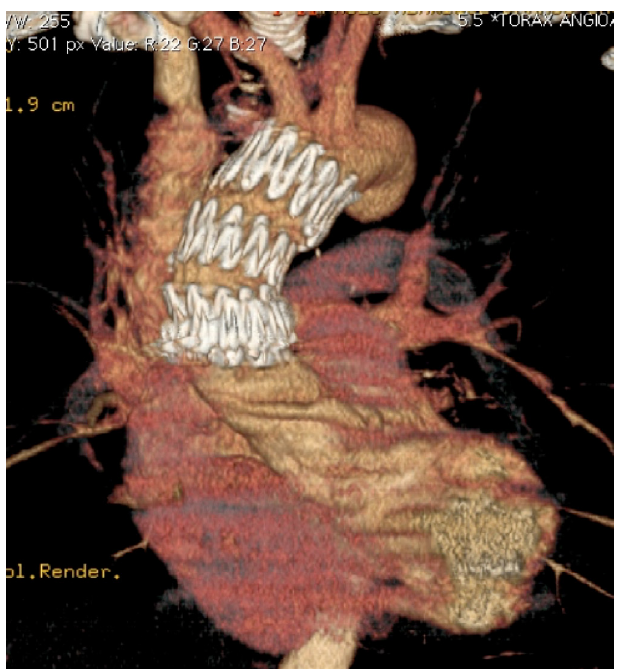
Fig. 5 – Three-dimensional computed tomography post stent graft in type A aortic